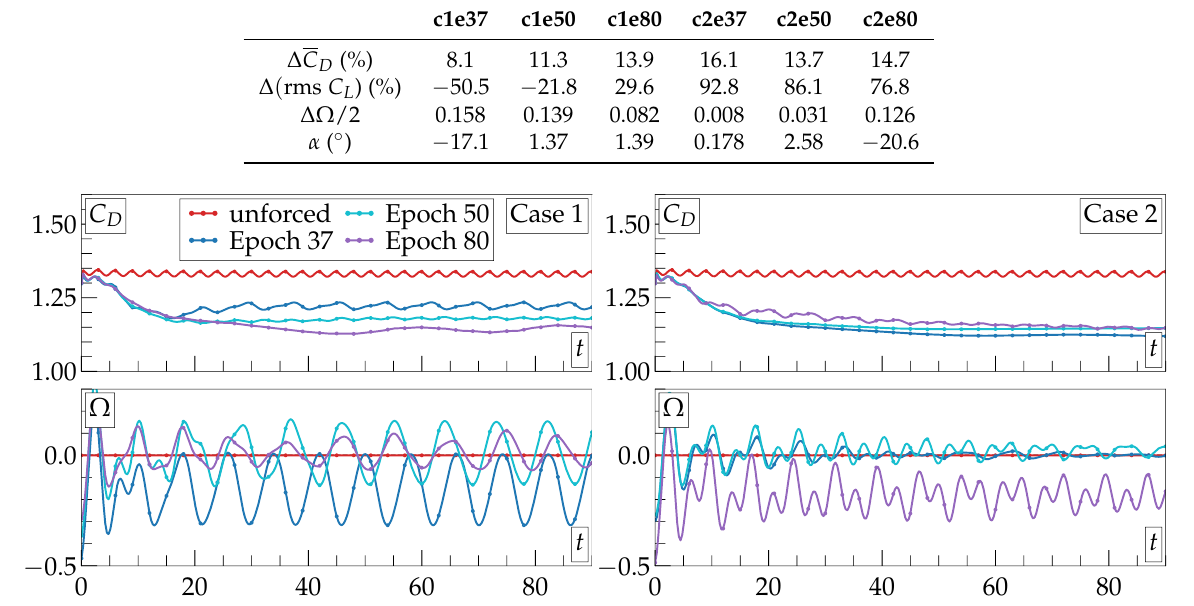
Figure 5. Evolution of C D and Ω for Cases 1 ( Left ) and 2 ( Right ) for different epoch number DRL-based control schemes in comparison with the stationary cylinder